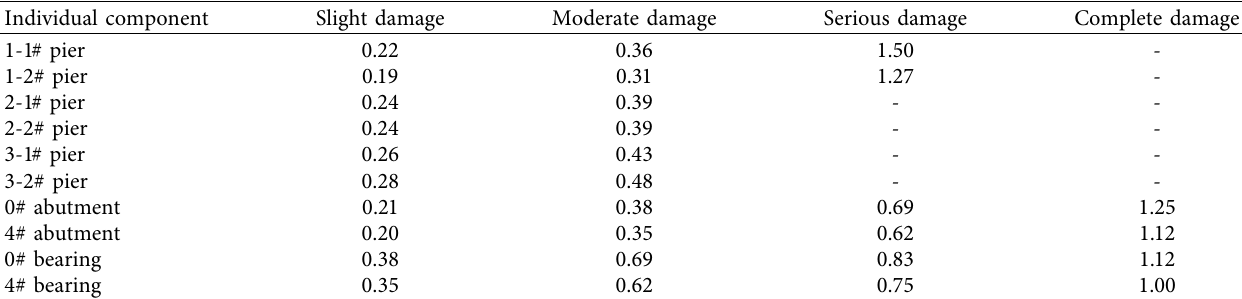
Table 6: Medians of component seismic vulnerability.